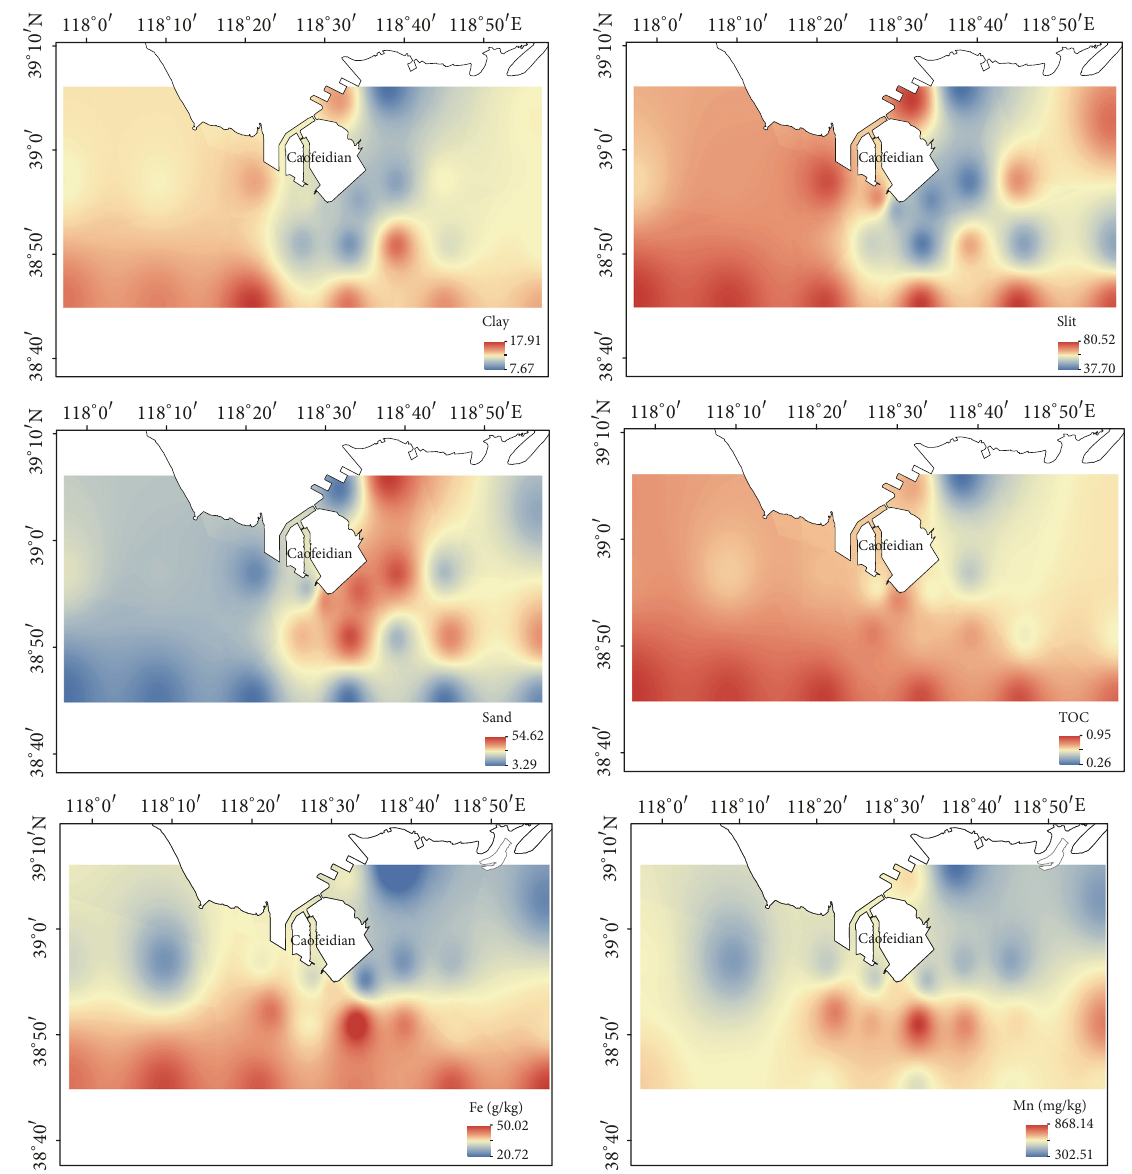
Figure 2: The spatial distribution of grain sizes, TOC, Fe, and Mn in the